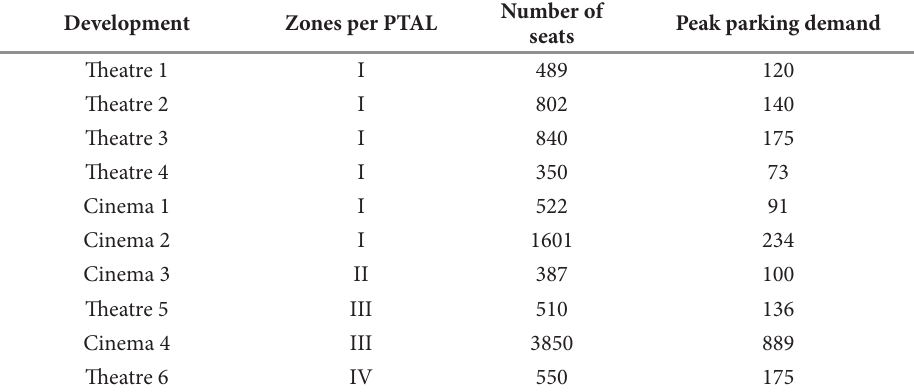
Table 6. Basic data on developments for definition of standards